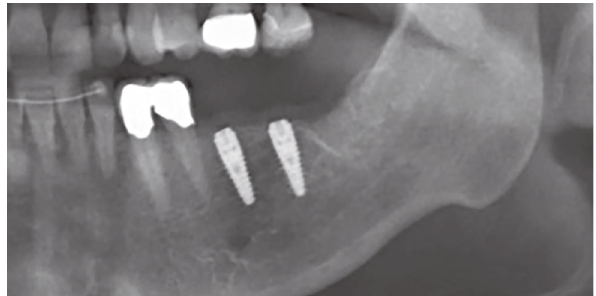
Figure 12: X-ray check after insertion.